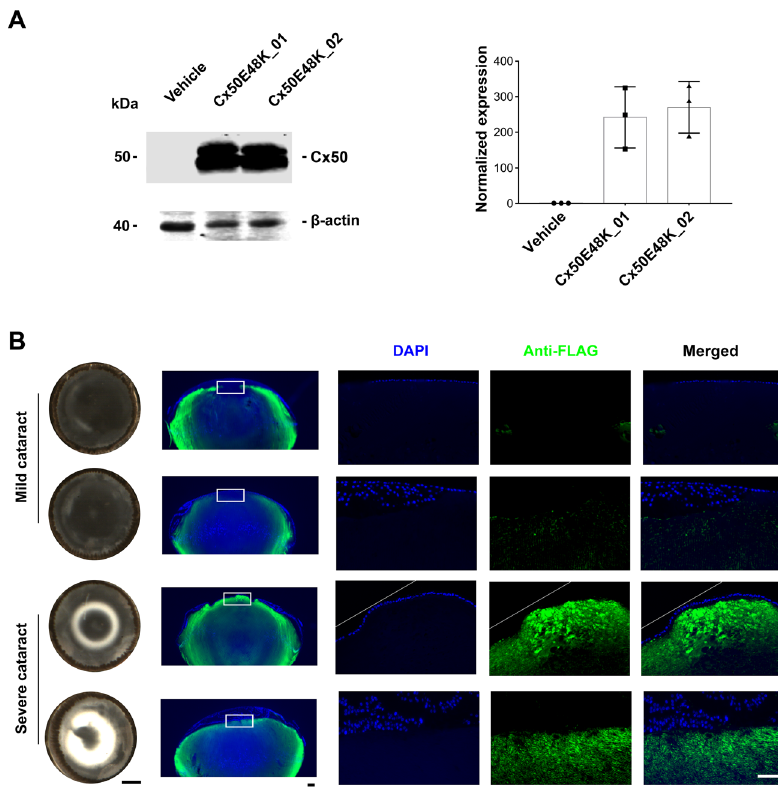
Fig. 5 Location of Cx50E48K expression at the anterior lens region de fi nes the severity of lens opacities. A Lysates of E14 chick lenses injected with a retrovirus containing vector or Cx50E48K (Cx50E48K_clones 01 and 02, representing lenses forming mild and severe cataracts, respectively) were immunoblotted with anti-FLAG or anti- β -actin antibody. B Paraf fi n tissue sections of E14 chick lenses were immunostained with anti-FLAG or anti- β -actin antibody, and images were captured by light transmission (left panels) and fl uorescence (right panels) microscopy. Scale bar for optical images, 400 µ m, and for fl uorescence images, 50 µ